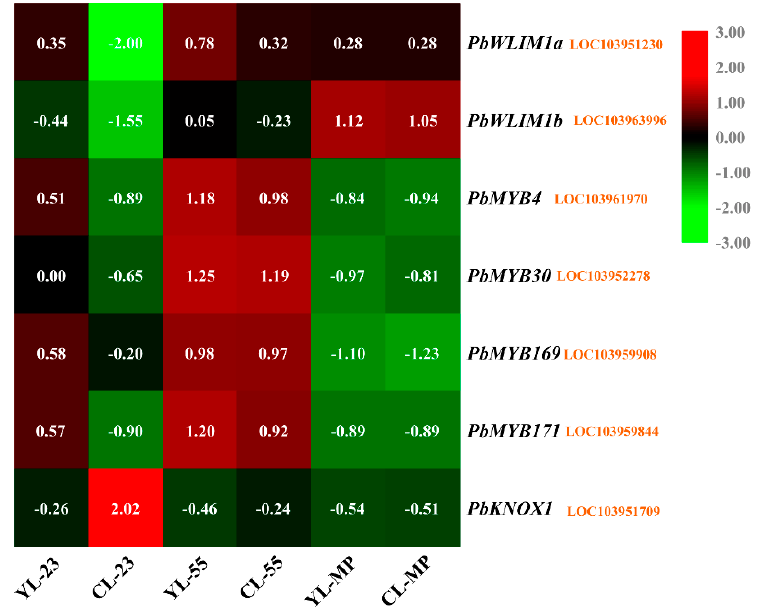
Figure 7. Expression profiles of lignin synthesis-related TFs at different developmental stages of YL and CL fruits. Fragments per kilobase of exon per million fragments mapped (FPKM) values were obtained by RNA-seq analysis and are presented as a heatmap. The heatmap was drawn while using TBTools v. 0.66836 software (College of Horticulture, South China Agricultural University, Guangzhou, China). CL-23: Fruit samples from CL at 23 DAF; CL-55: Fruit samples from CL at 55 DAF; CL-MP: Fruit samples from CL at mature period; YL-23: Fruit samples from YL at 23 DAF; × ‘Lianglizaosu’